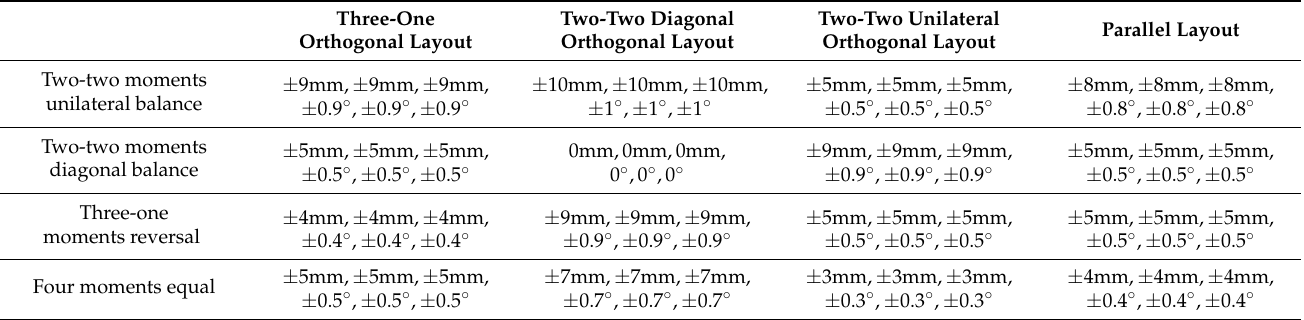
Table 4. Layout tolerance capability of 16 capture and lock systems (measured in